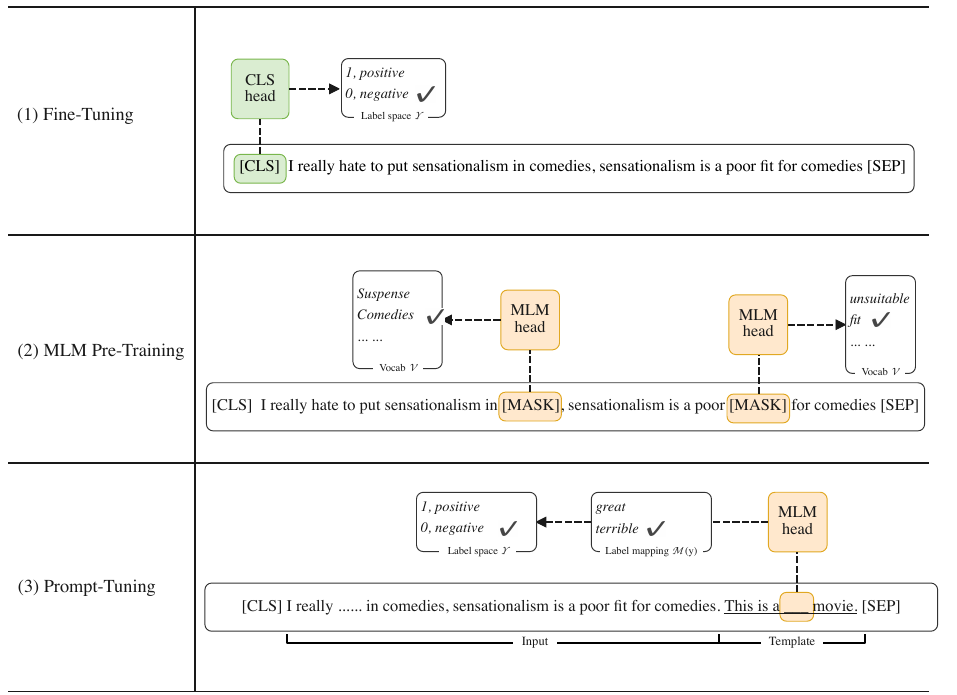
Figure 1. The example of fine-tuning, masked language modeling, and prompt-tuning. (1) The Fine-Tuning approach uses the representation of the headers special token as the representation of the whole sentence for prediction, (2) the masked language modeling (MLM) obtains the sentence representation by masking some words for the model to predict, and (3) the prompt-based fine- tuning (prompt-tuning) method allows the model to predict the textual answers directly by adding a sequence with a mask as a